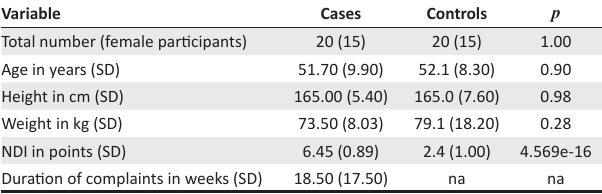
* , Statistically significant TABLE 1: Baseline characteristics of